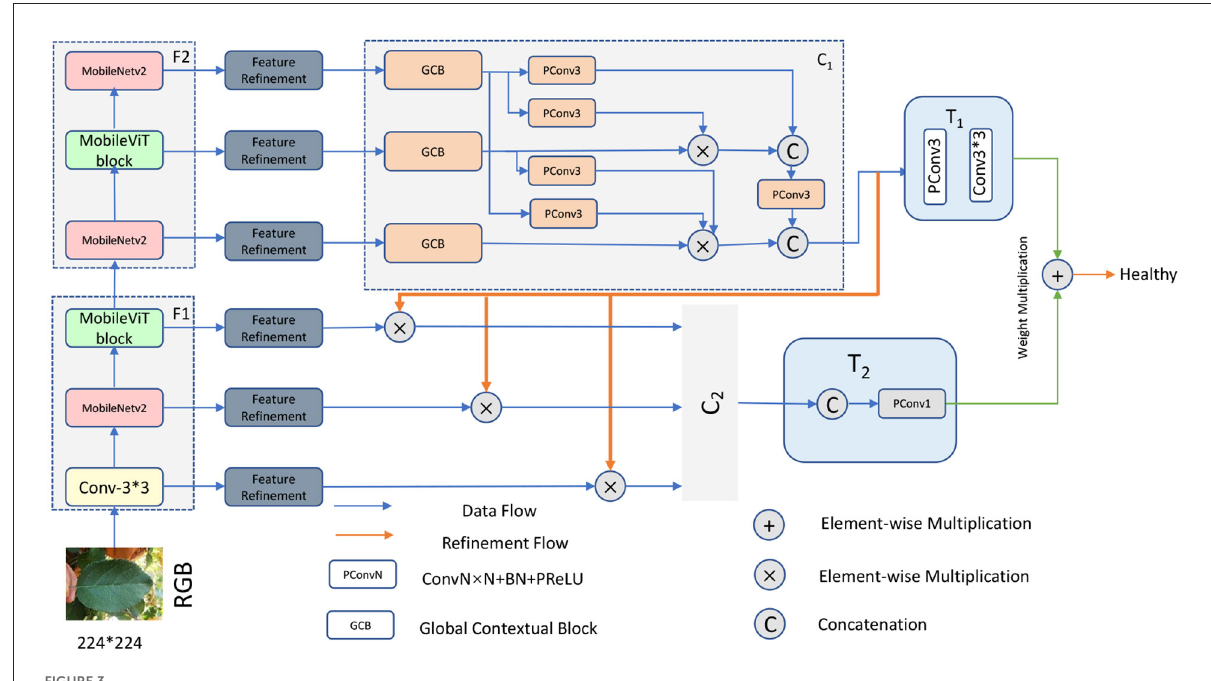
FIGURE3 Architecture diagram of our proposed